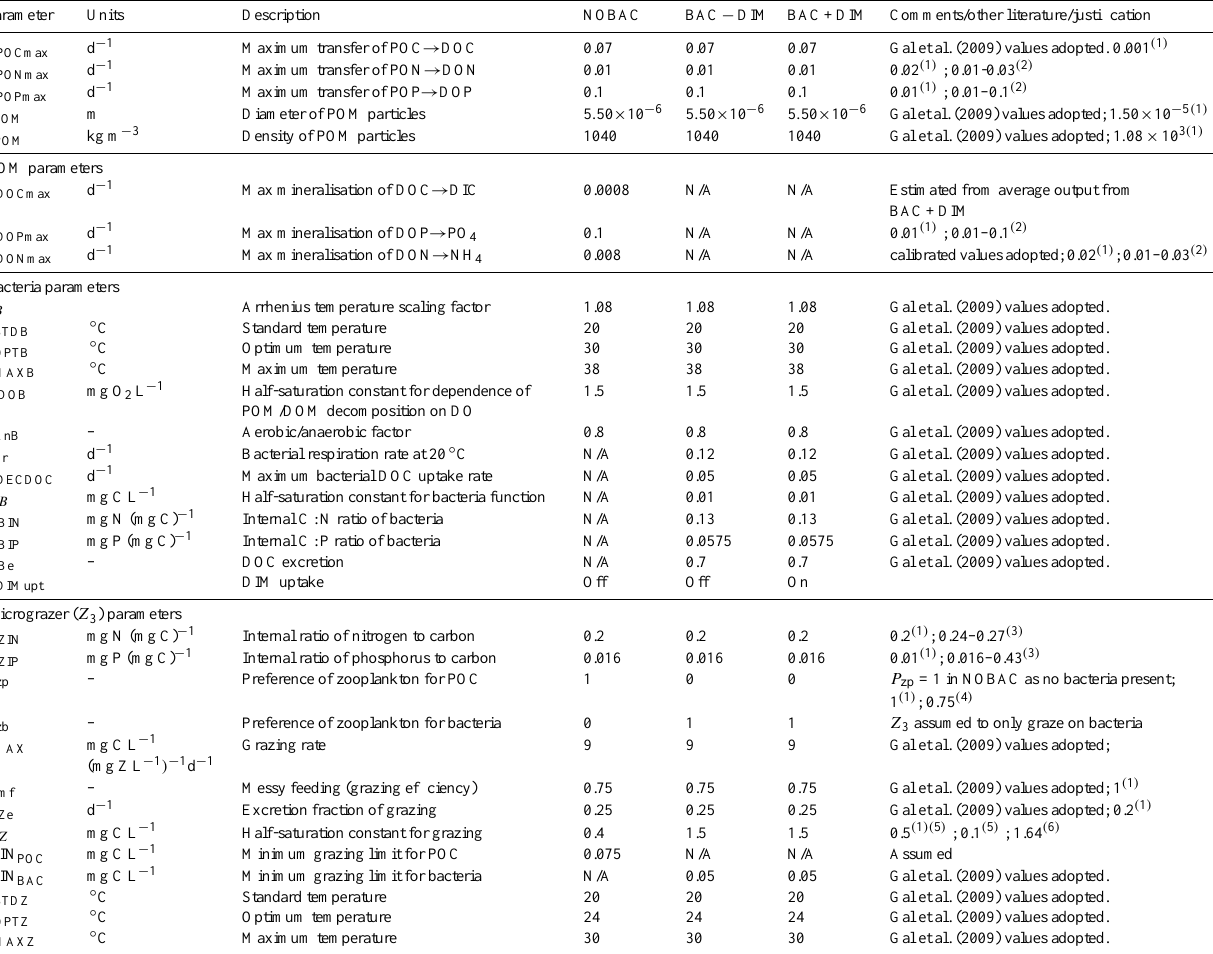
Table 4. Microbial-loop related parameters used in the three model simulations (refer to Gal et al. (2009) for other parameter values).